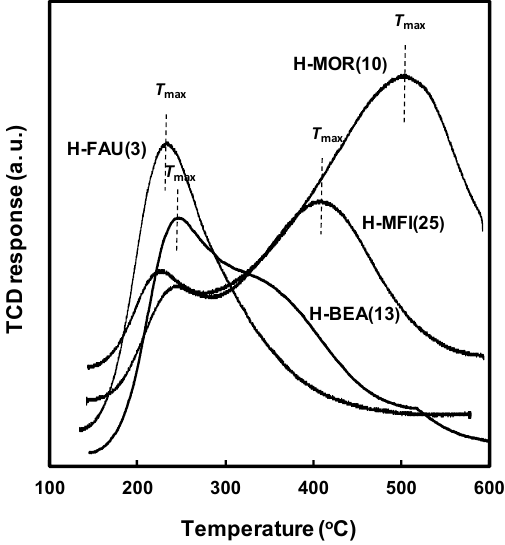
Figure 2. NH 3 ‐ TPD profiles of the zeolite catalysts.